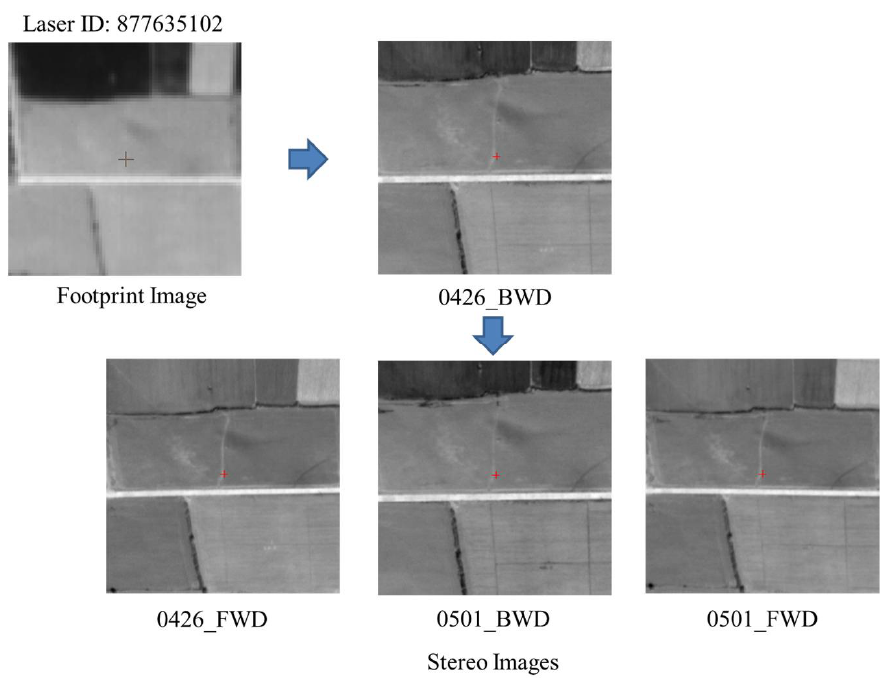
Figure 7. Registration results in weak-textured area.